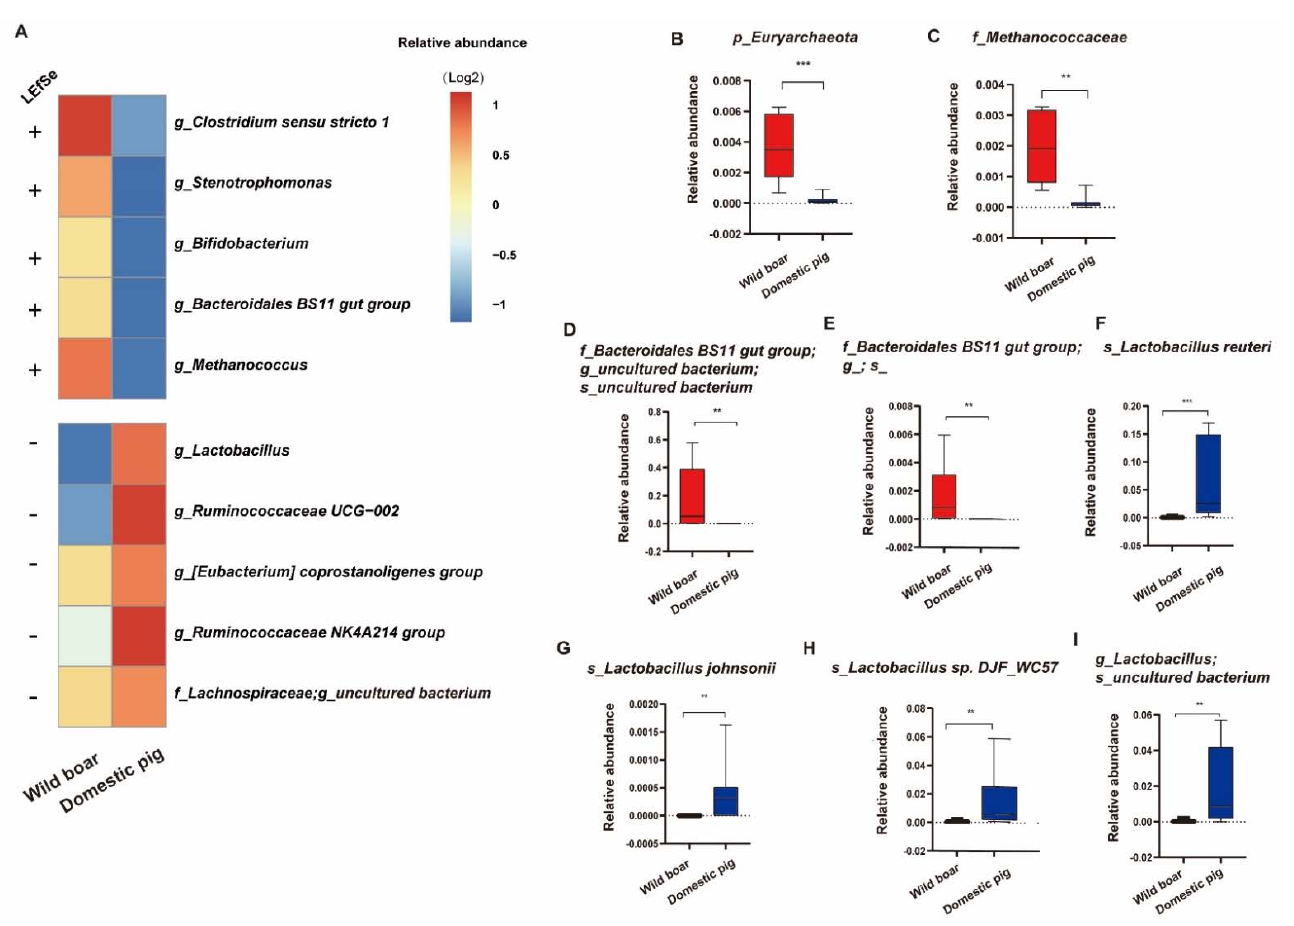
Figure 3. Differences in bacterial communities between wild boars and domestic pigs. ( A ): The average relative abundance of the LEfSe-identified bacterial taxa in the wild boars and domestic pigs is plotted as a heatmap. “+” indicates significantly high abundance in wild boars, “-” indicates significantly high abundance in domestic pigs ( p < 0.05, LDA cutoff = 2.0). Differential gut microbiota at the genus level: ( B ): p_Euryarchaeota , ( C ): f_Methanococcaceae. ( D – I ): Differential gut microbiota at species level: ( D ): f_Bacteroidales BS11 gut group ; g_uncultured bacterium ; s_uncultured bacterium , ( E ): f_Bacteroidales BS11 gut group ; g_; s_, ( F ): s _Lactobacillus reuteri , ( G ): s_Lactobacillus johnsonii , ( H ): s_Lactobacillus sp.DJ_WC57 , ( I ): g_Lactobacillus; s_uncultured bacterium , Whitney U ‐ test, ** p < 0.01, *** p < 0.001. The red bars and blue bars represent wild boars and domestic pigs. The line in the box represents the middle value, and the error bars represented the lowest and highest values, respectively.